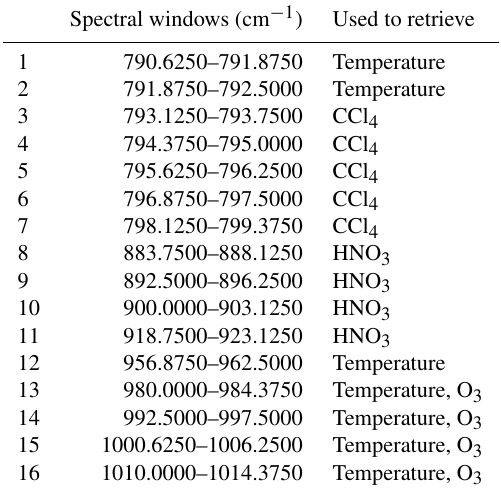
Table A1. Spectral windows used during